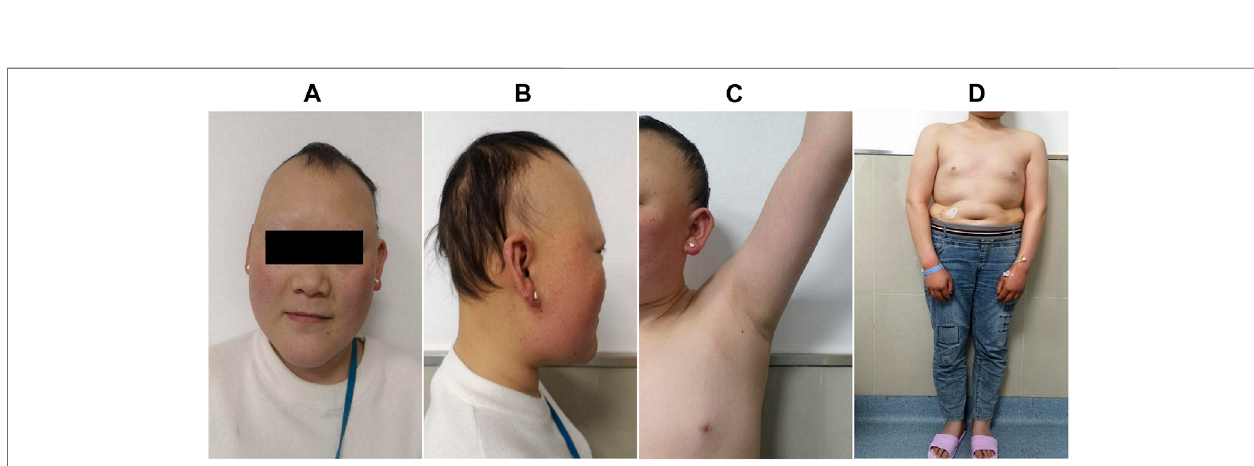
FIGURE2| Clinicalmanifestationsoftheproband.Shepresentedwithsparsehair,especiallyonbothtemporalsidesandontheforehead,withaprogericfaceand a large forehead with prominent ears (A , B) . Secondary sexual characteristics were incompletely developed (C , D) .